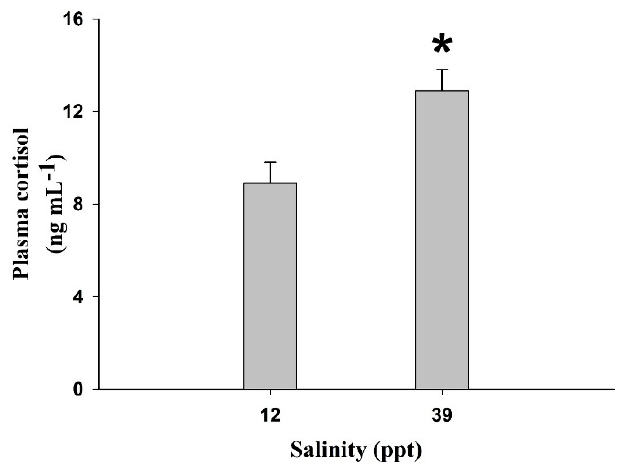
Figure 2. Plasma cortisol concentrations in A. regius fingerlings acclimated to 12 and 39 ppt salinity conditions for 45 days. Data are expressed as the mean ± SEM ( n = 9). Asterisks (*) indicate significant differences among groups ( p < 0.05, Student’s t -test).